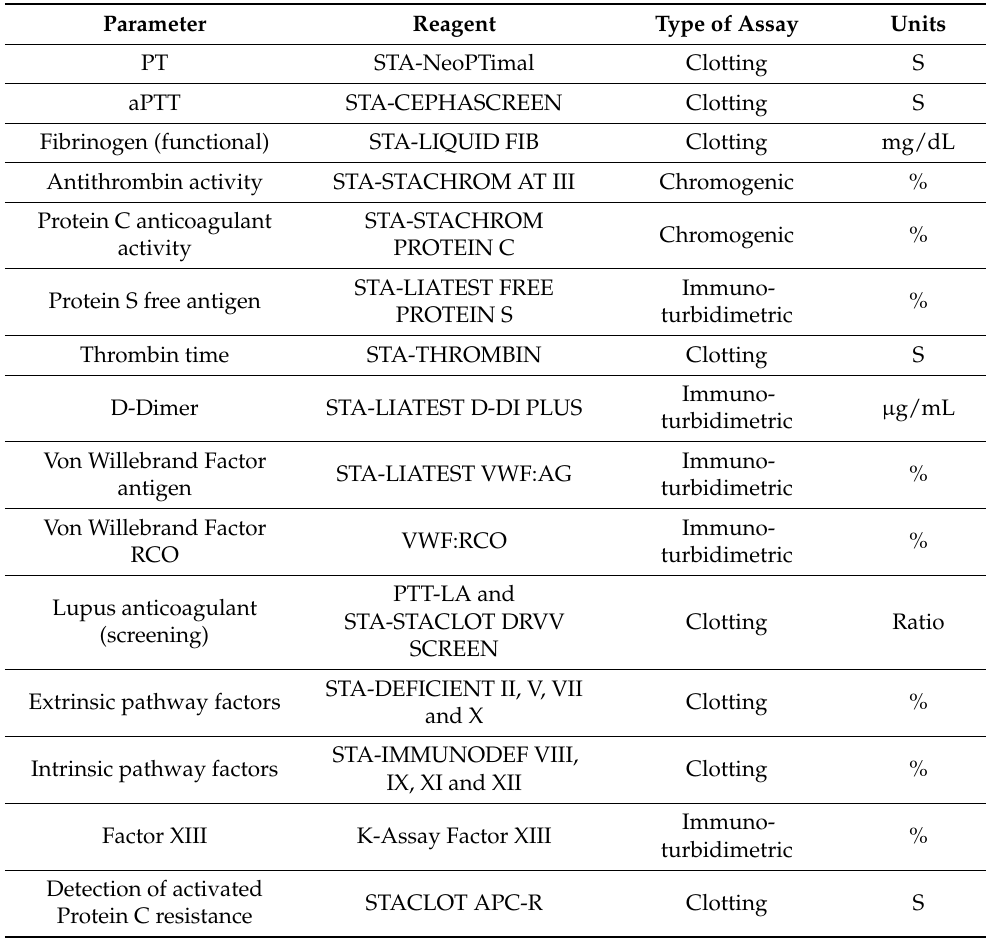
Table 1. List of parameters included in the pediatric reference interval range study, related reagents, type of assay, and reported units. PT: prothrombin time; aPTT: activated partial thromboplastin time; s: